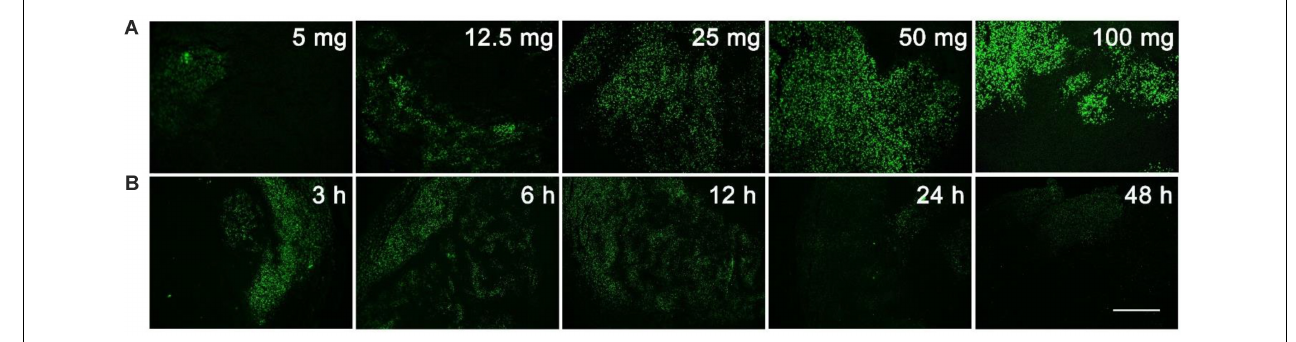
FIGURE 1 | Screening for the optimal dosage and administration time of EdU labeling. (A) Various dosage (5, 12.5, 25, 50, or 100 mg/kg) of EdU was intraperitoneally injected to mice for 12 h. (B) 50 mg/kg EdU was intraperitoneally injected to mice for various times (3, 6, 12, 24, and 48 h). Scale bar indicates 2